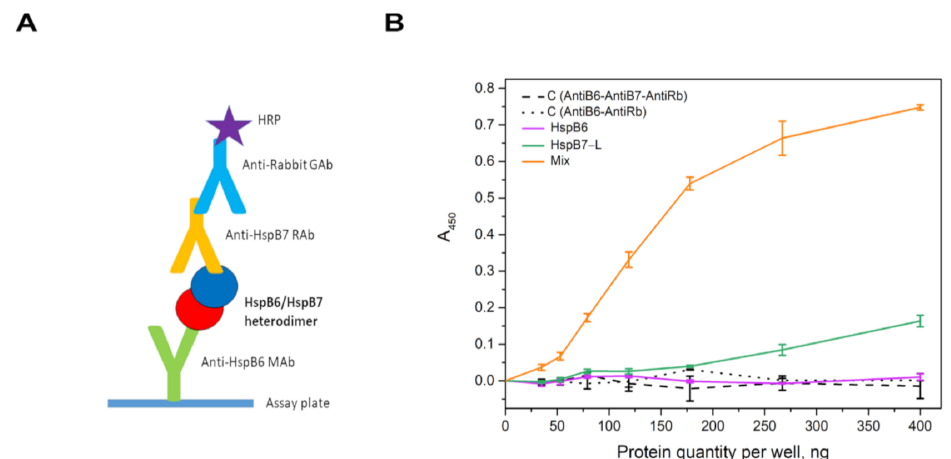
Figure 6. ( A ) Detection of HspB6 and HspB7 hetero-oligomers by means of sandwich ELISA method. Immunological plate was coated with monoclonal mouse anti-HspB6 antibodies (MAb) used as a cap- ture antibody. Rabbit polyclonal monospecific anti-HspB7 antibodies (RAb) recognized only HspB7 retarded on the plate due to its interaction with HspB6. Anti-HspB7 antibodies were detected by HRP-conjugated goat anti-rabbit immunoglobulin antibodies (GAb). ( B ) Isolated HspB6 (magenta), isolated HspB7 (green) or equimolar mixture of HspB6 and HspB7 (orange) were added to mouse anti- HspB6 antibody immobilized on the immunological plate. HspB7 was detected by rabbit anti-HspB7 antibodies followed by HRP-conjugated goat anti-rabbit antibodies. In control experiments, immobi- lized anti-HspB6 antibodies were incubated either with anti-HspB7 antibodies + HRP-conjugated anti-rabbit antibodies (dashed line) or only with HRP-conjugated anti-rabbit antibodies (dotted line). Data presented are means of three independent experiments ±